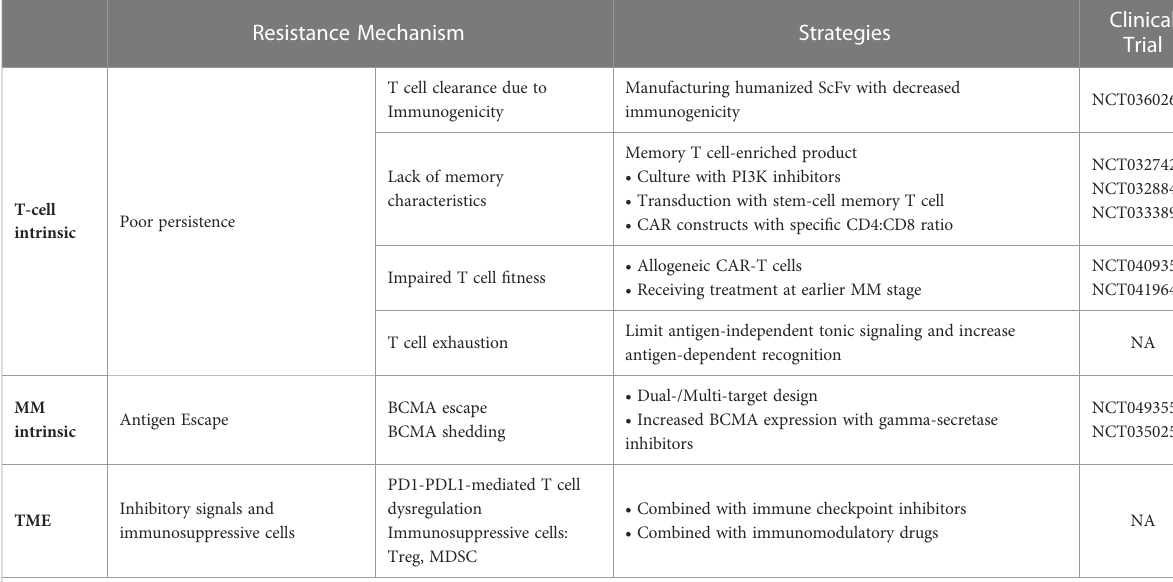
TABLE 3 Mechanisms of resistance to MM CAR-T and strategies to overcome the